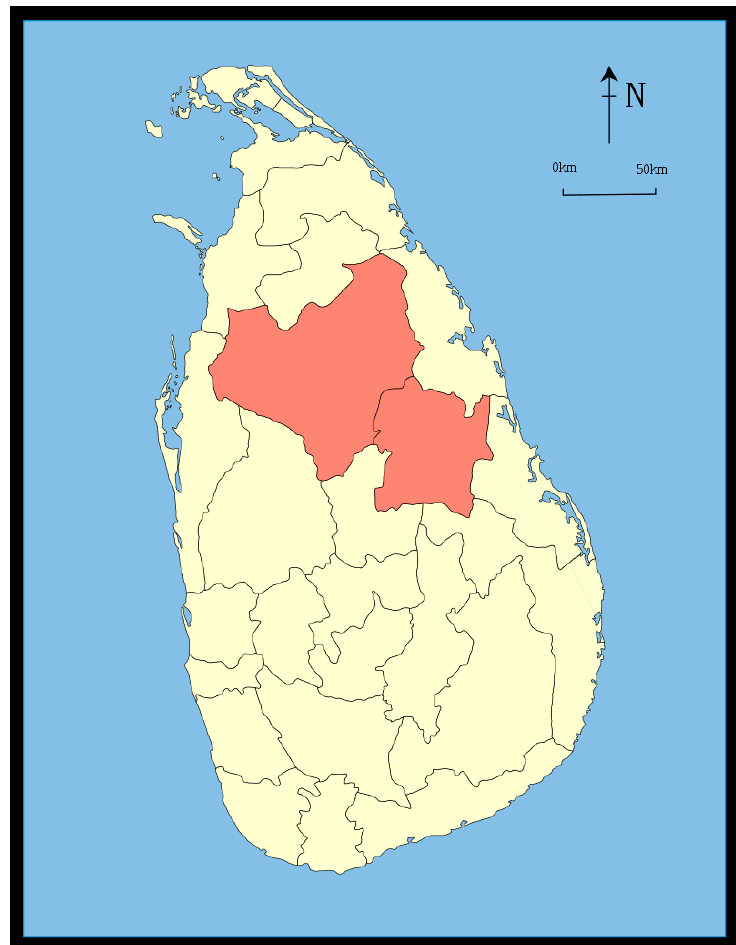
Figure 1. The North Central Province of Sri Lanka (highlighted in red) Reproduced with permission from [The Planning and Monitoring Unit of the Mahaweli Authority of Sri Lanka]; [2018].